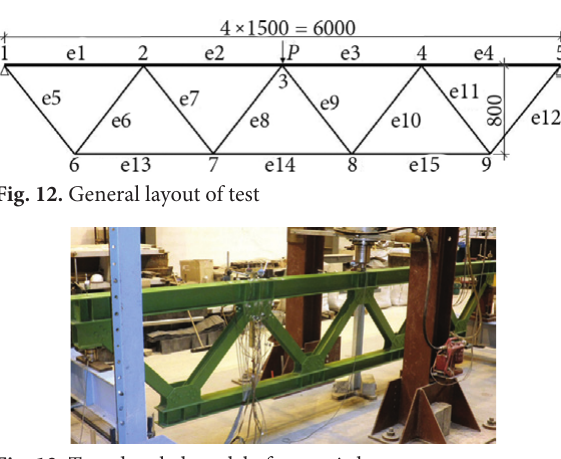
Fig. 13. Tested scaled model of truss girder